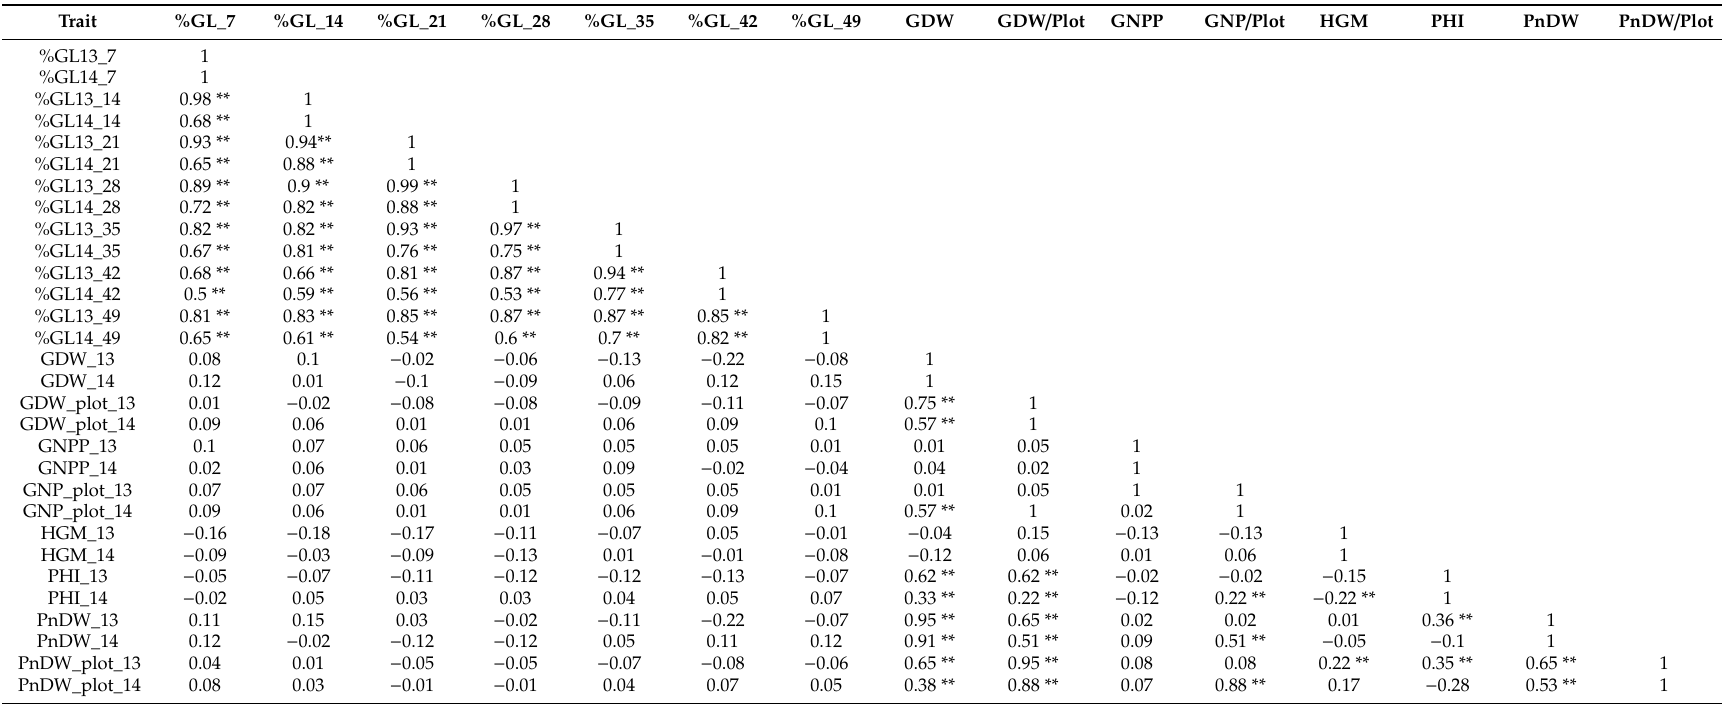
Table 3. Correlation between stay-green weekly scores with grain yield for E1 &